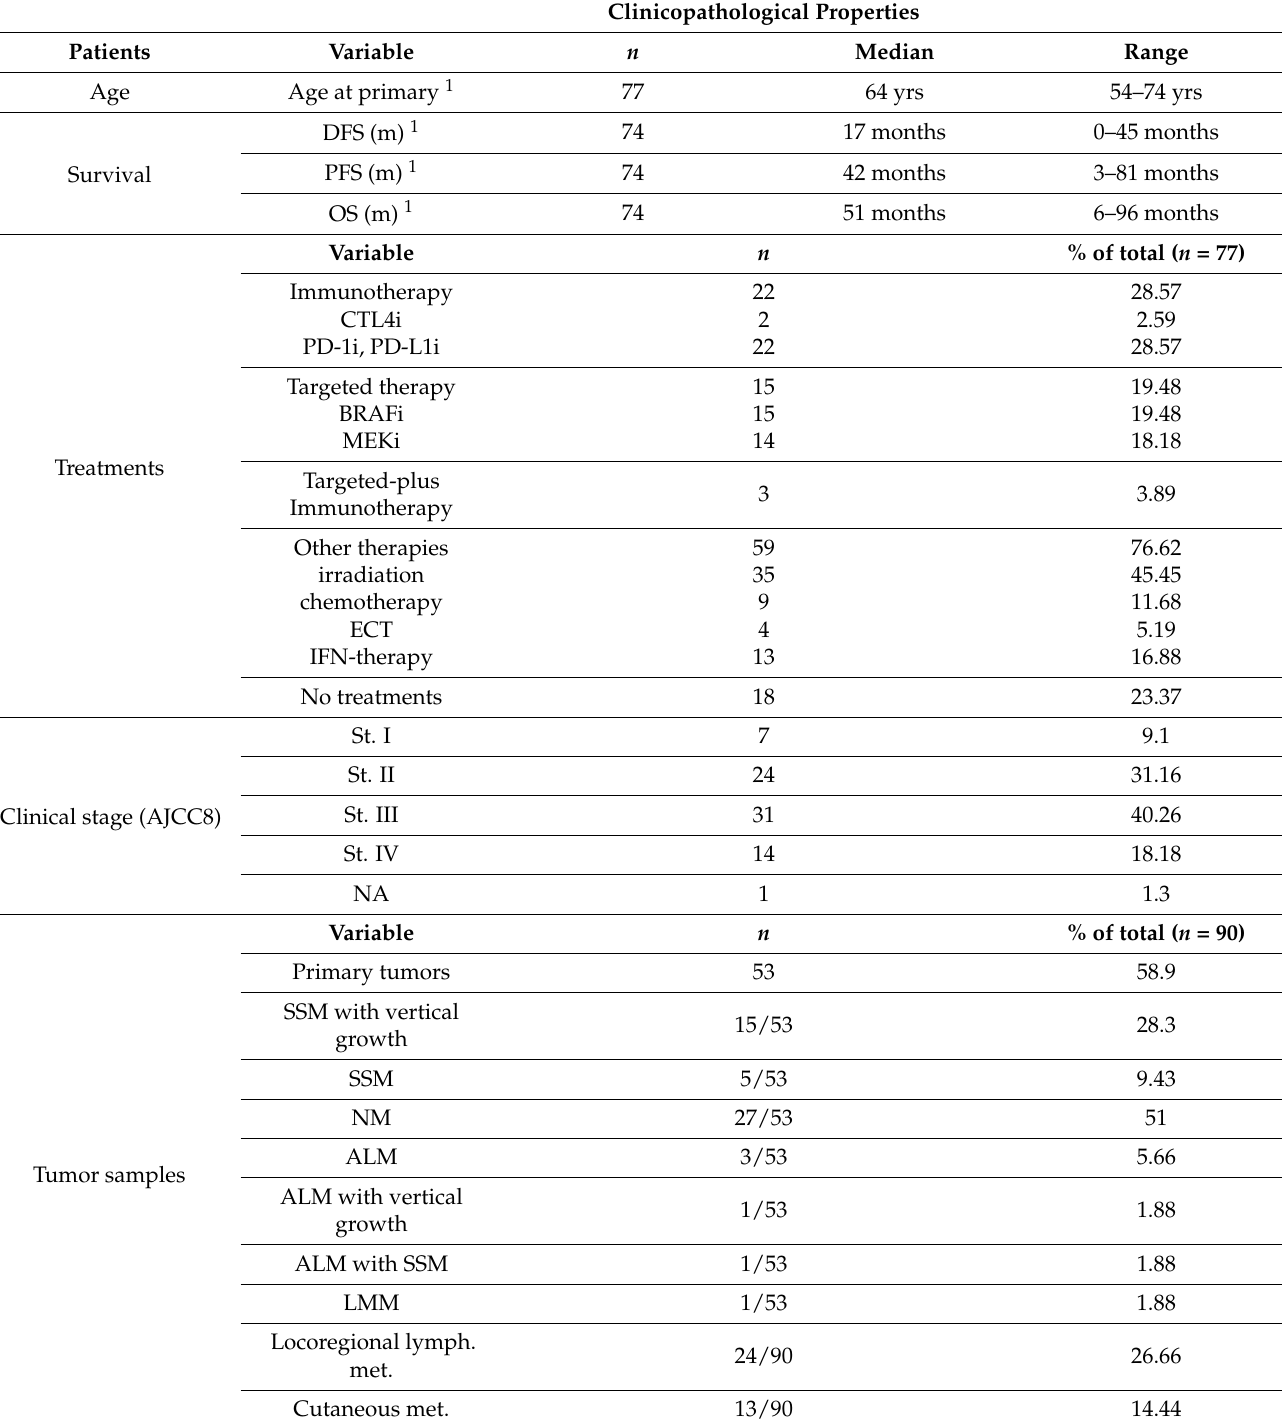
Table 1. Clinicopathologic data of the patient cohort. Clinicopathological